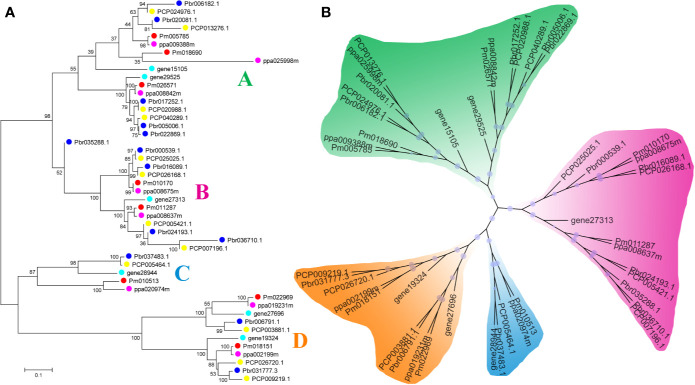
Phylogenetic trees of the five Rosaceae species BZR proteins. (A) A phylogenetic tree made by the neighbor-joining method with MEGA 5.0 software. (B) A phylogenetic tree generated by the maximum-likelihood method with IQ-tree software. These trees were divided into four groups, designated as A, B, C and D.